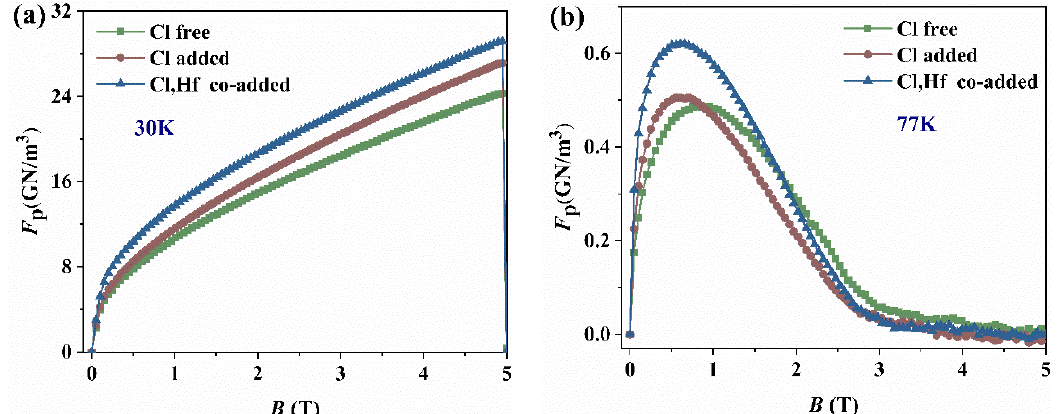
Figure 6. The magnetic pinning force of Cl-free, Cl-added and (Cl, Hf) co-added YBCO samples at ( a ) 30 K, ( b ) 77 K.